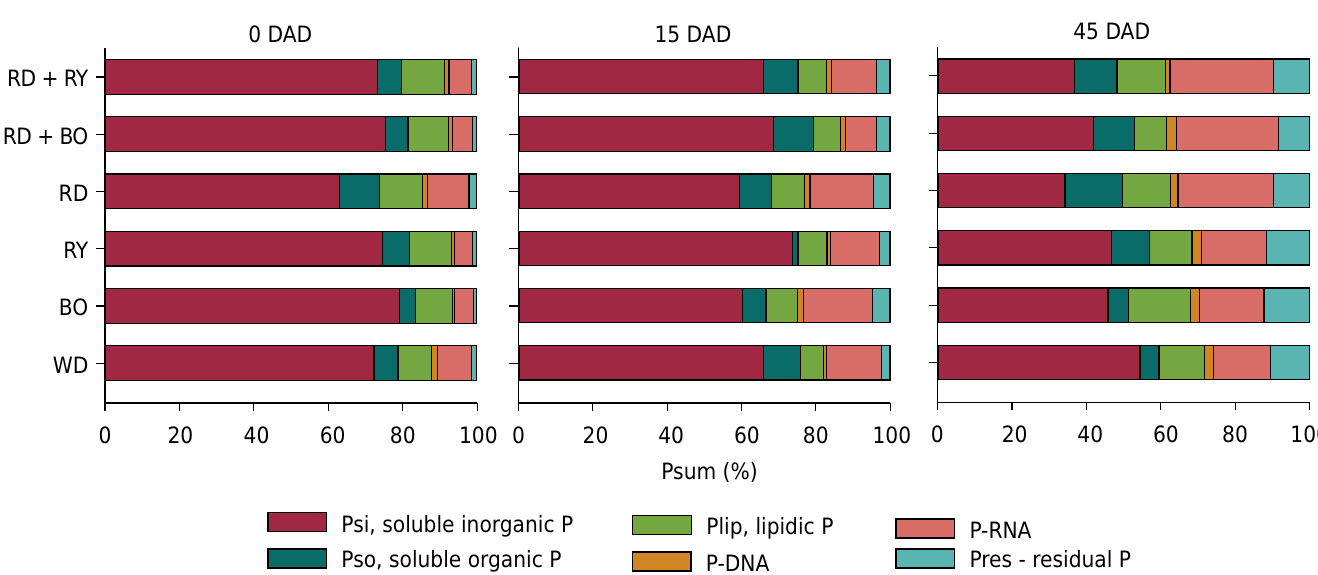
Figure 4. Relative percentage of P fractions in the plant tissue of the residues of weed (WD), black oat (BO), rye (RY), oilseed radish (RD), oilseed radish + black oat (RD + BO), and oilseed radish + rye (RD + RY) extracted by chemical fractionation proposed by Miyachi and Tamiya (1961) with adjustments proposed by Schmidt and Thannhauser (1945) and Casali et al. (2011) in cover crop residues at the time of deposition of cover crop residues on the soil (time 0) and at 15 and 45 days after the deposition (DAD) of litterbags on the soil surface in agroecological no-till